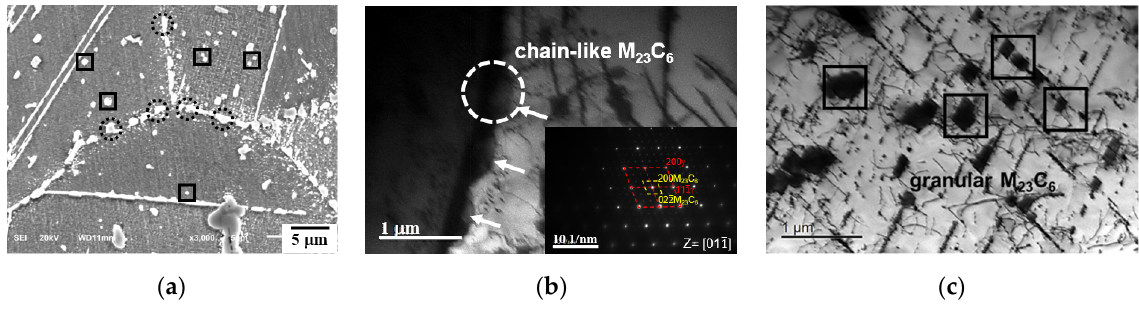
Figure 8. Distribution of M 23 C 6 in the 9411 h crept specimen: ( a ) SEM micrographs of two kinds of M 23 C 6 , ( b ) TEM micrographs of coarsened M 23 C 6 distributed along the grain boundary, and ( c ) TEM micrographs of fine M 23 C 6 in the grain interior. Precipitates in dotted circles indicate chain-like M 23 C 6 at the grain boundary and precipitates in solid rectangles indicate granular M 23 C 6 in the grain interior. The ECCI micrographs of precipitations in the grain boundaries are shown in Figure 9.